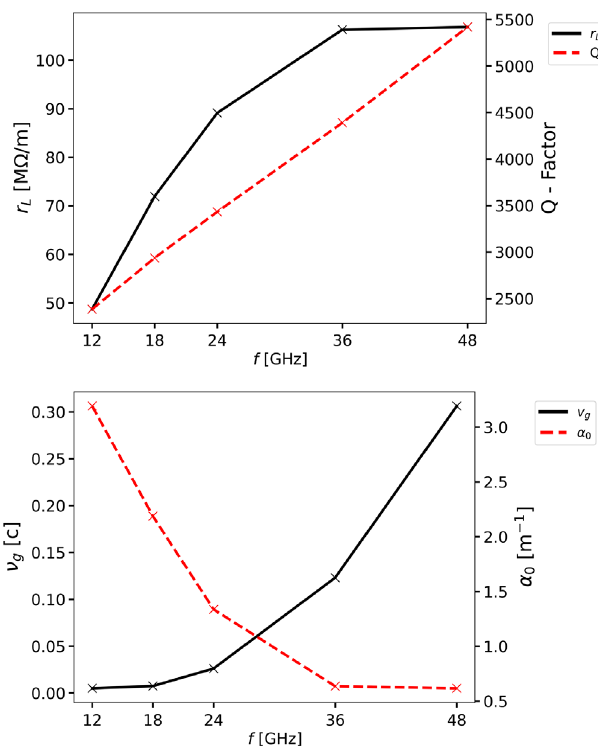
FIG. 4. Parameter comparison of a 2 π = 3 single cell at different frequencies for a 2-mm iris radius.